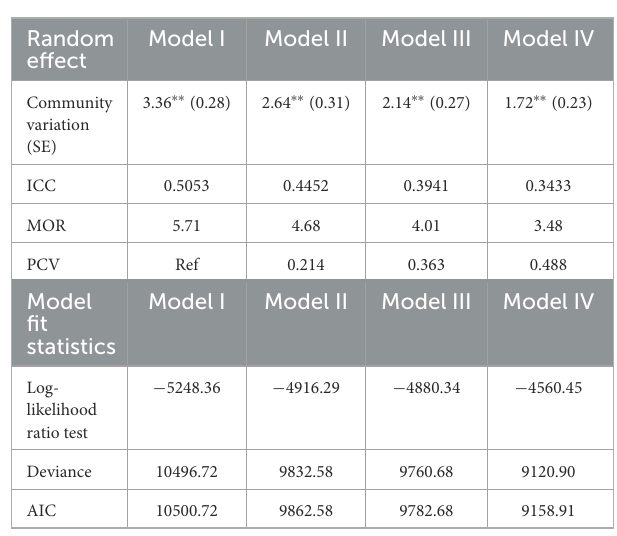
TABLE 2 The prevalence of substance use in Ethiopia, 2016 (weighted data).